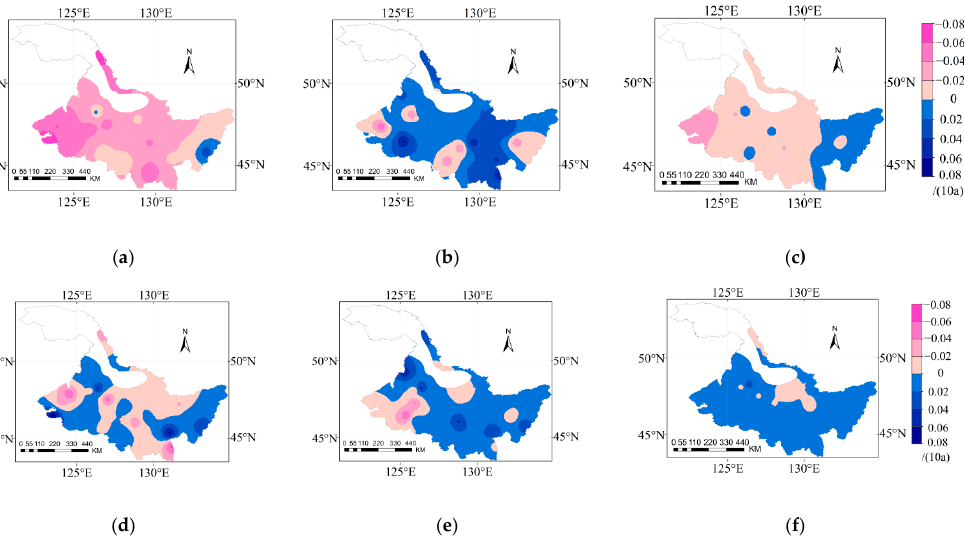
Figure 10. Spatial distribution of CD during the ( a ) 2030s, ( b ) 2050s, and ( c ) 2070s under RCP4.5, and during the ( d ) 2030s, ( e ) 2050s, and ( f ) 2070s under RCP8.5 during the soybean growth period.